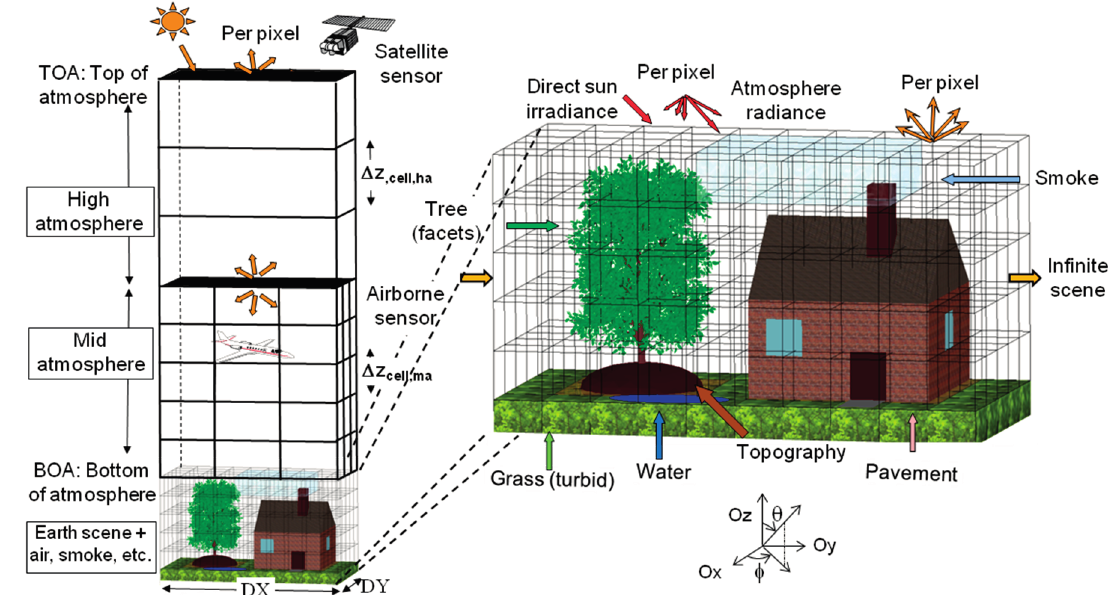
Figure 1. DART cell matrix of the Earth/Atmosphere system. The atmosphere has three vertical levels: upper ( i.e ., just layers), mid ( i.e ., cells of any size) and lower atmosphere ( i.e. , same cell size as the land surface). Land surface elements are simulated as the juxtaposition of facets and turbid